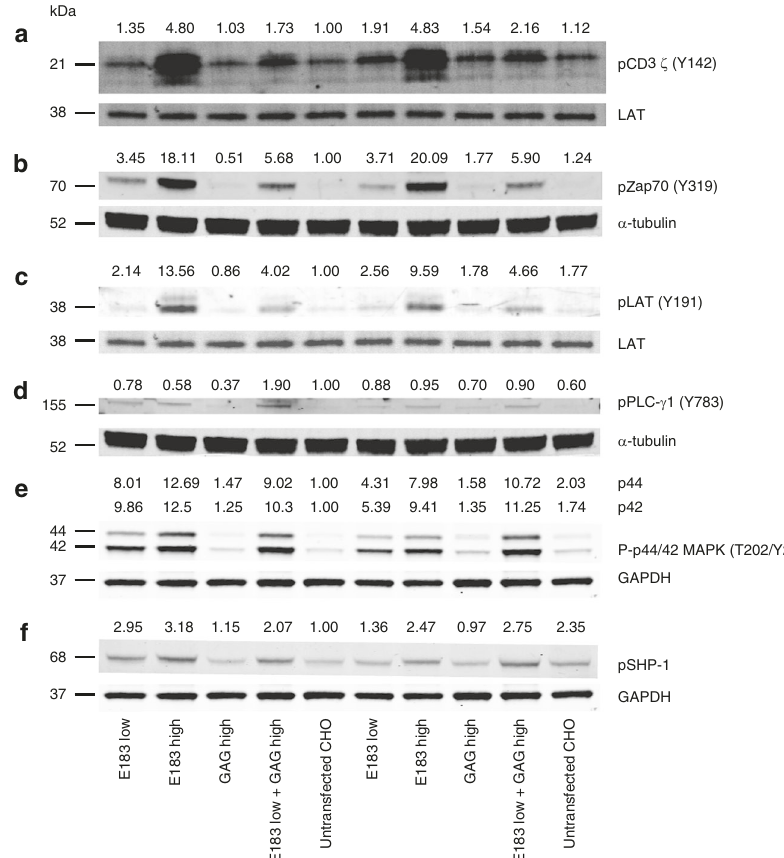
Fig. 7 Coagonist pMHC enhance human T-cell response to antigens by increasing phosphorylation of molecules involved in proximal TCR signaling pathway. Human E183 CTL were stimulated by T-REx CHO cells panel for 5 or 30 min, lysed and the lysate was separated on NuPAGE Bis-Tris Gel. The fi lter was blotted with antibodies against pCD3 ζ ( a ), pZap70 ( b ), pLAT ( c ), pPLC- γ 1 ( d ), p-Erk1/2 ( e ), and pSHP-1 ( f ). The data are representative of three independent experiments. Uncropped western blotting images are presented in Supplementary Fig.